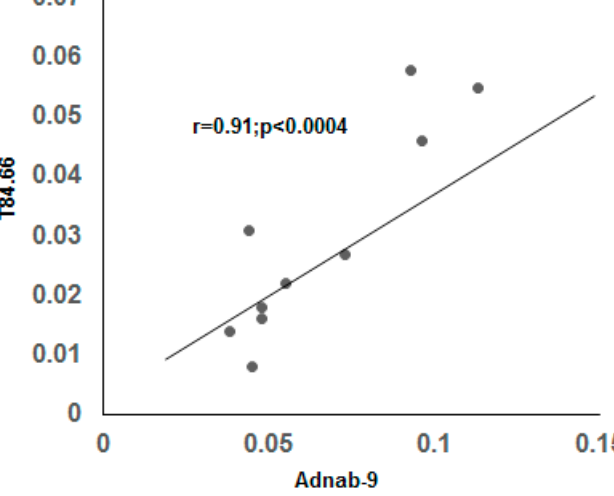
Figure 10. The correlation between Adnab-9 antibody binding and T84.66 antibody binding to CTT cancerous and normal tissue extracts. The scatter gram plot shows a statistically significant correlation between Adnab-9 and CEA. There was no correlation between Adnab-9 and anti-CEA T84.66 binding in CM